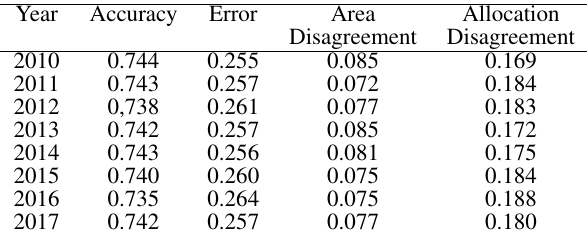
Table 2. The accuracy global for the level 2 of legend MapBiomas.